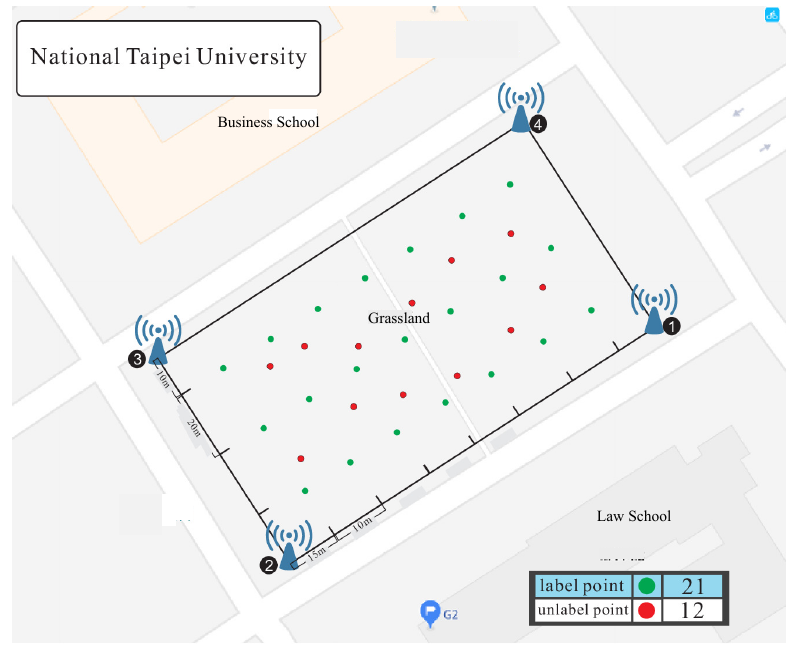
Figure 11. The experimental environment of the small